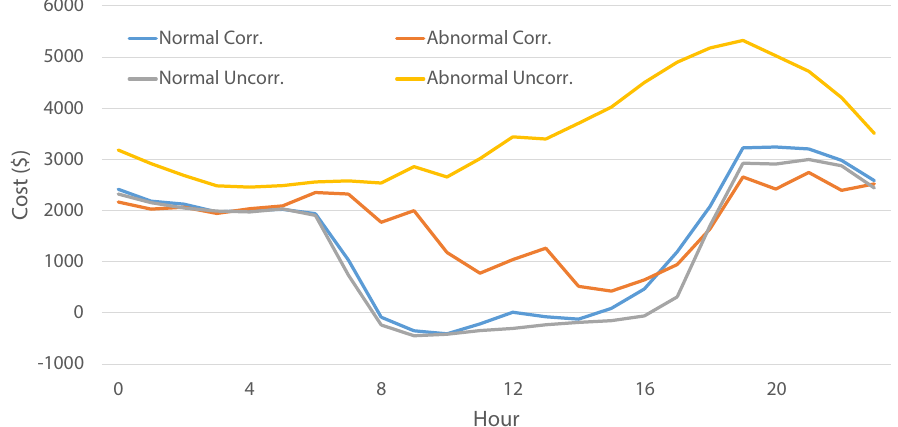
Figure 17. Shoulder normal − abnormal comparison (ratio =